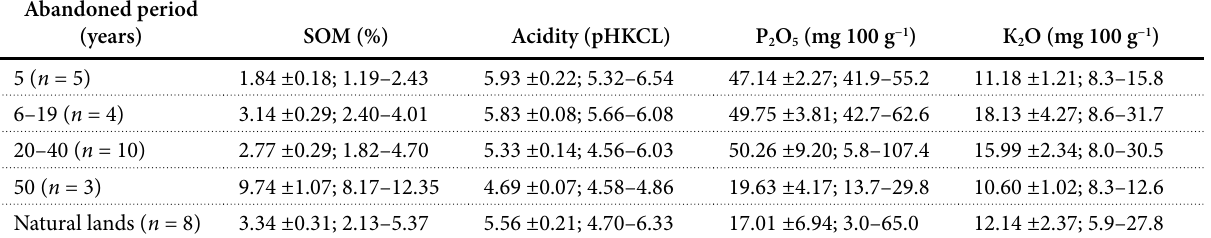
Tab. 3 Dynamics of agrochemical properties of the arable horizon soils on postagricultural succession. Abandoned period (years)